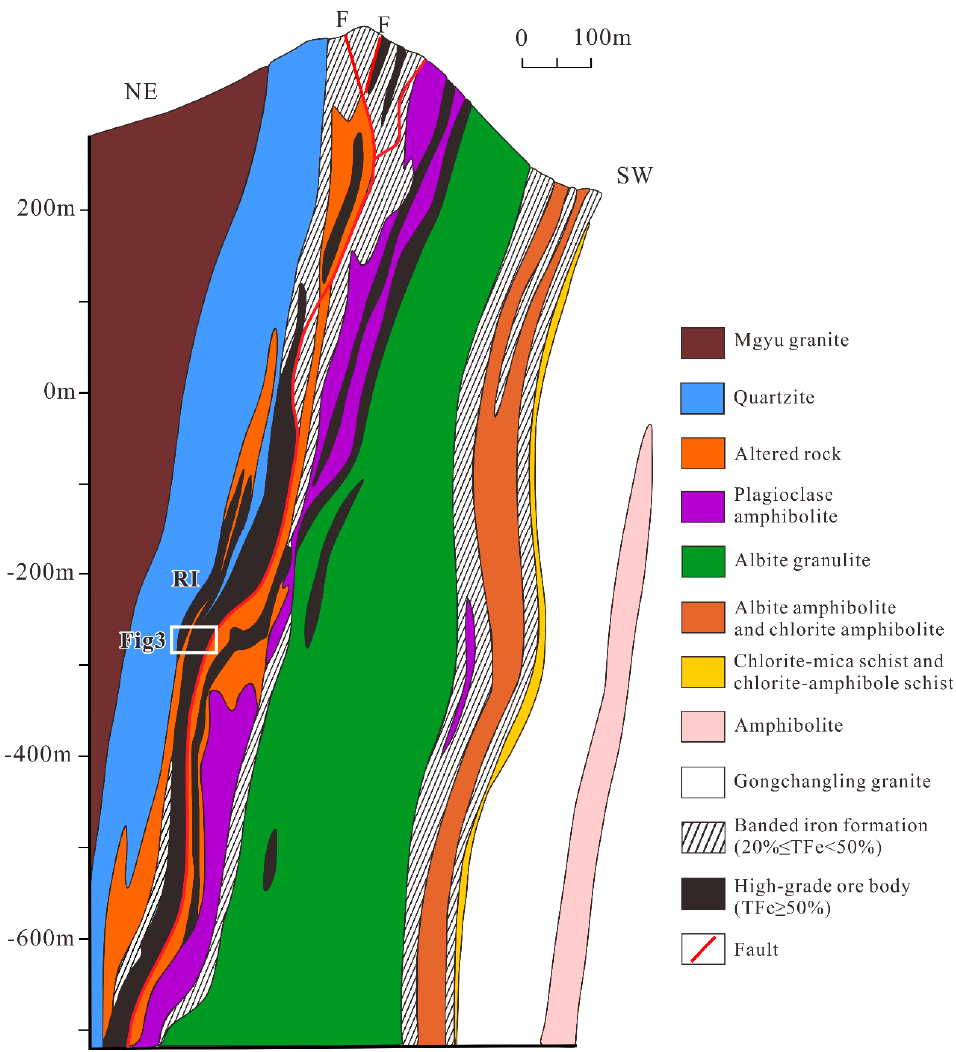
Figure 2. Geological cross-section of the Gongchangling number 2 mining area. Modified after [27,29]. Appl. Sci. 2020 , 10 , x FOR PEER REVIEW